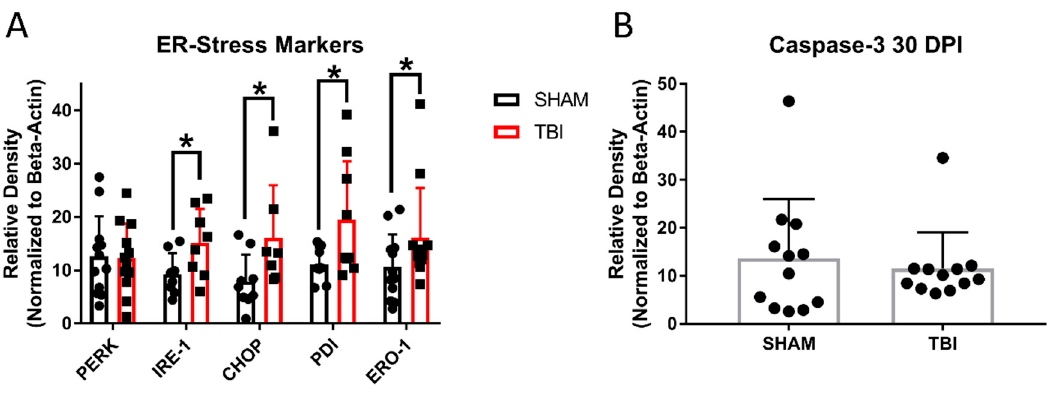
Figure 11. Markers of endoplasmic reticulum stress ( A ) and caspase-3 expression ( B ) at 30 DPI. * p < 0.05.